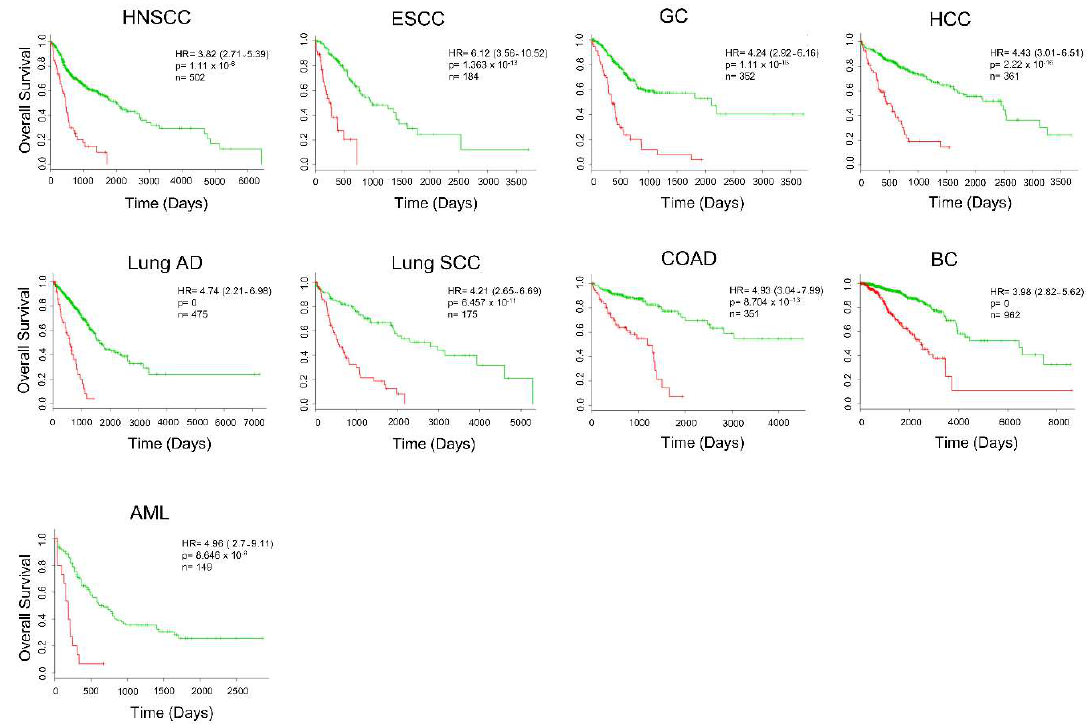
Figure 7. The expression of secretome genes predicts cancer outcomes. Survival analysis based on the expression of 39 transcripts translated into secreted proteins by using the online platform SurvExpress [107] in nine The Cancer Genome Atlas (TCGA) studies. Cancer patients were stratified into high- (red) and low-risk (green) groups. The adjusted risk ratio (HR) with the corresponding 95% confidence interval, log-rank p -value (P), and the number of successfully stratified patients (N) determined by Cox univariate regression analysis is shown in each Kaplan–Meier survival plot.